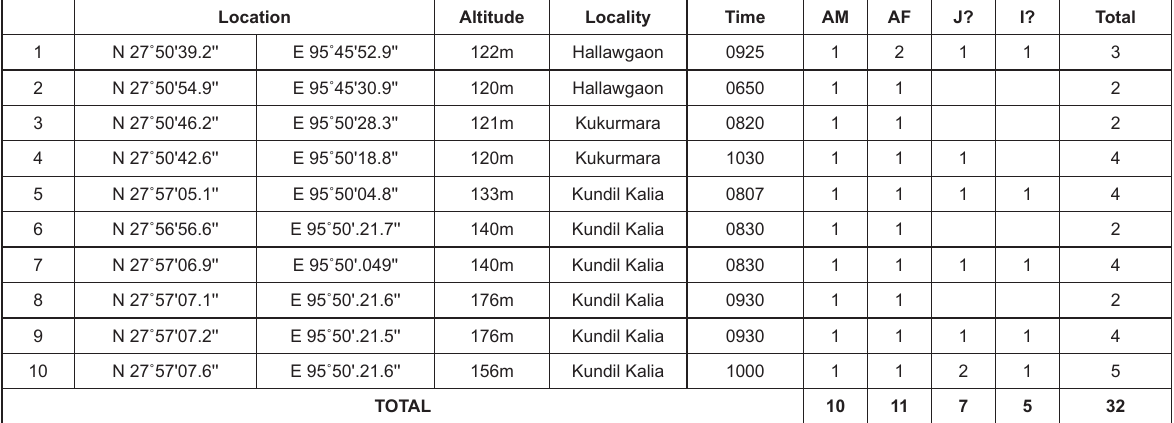
Table 1. Sighting records of Eastern Hoolock Gibbon Location